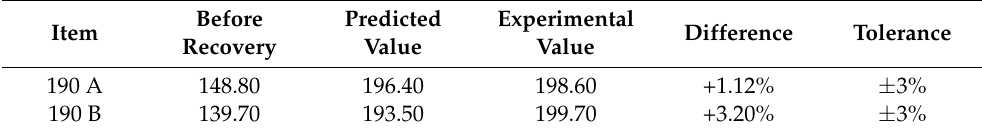
Table 7. Comparison of predicted and experimental values.